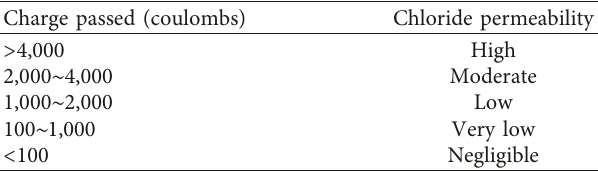
Table 7: Standard of permeability levels by ASTM. Charge passed